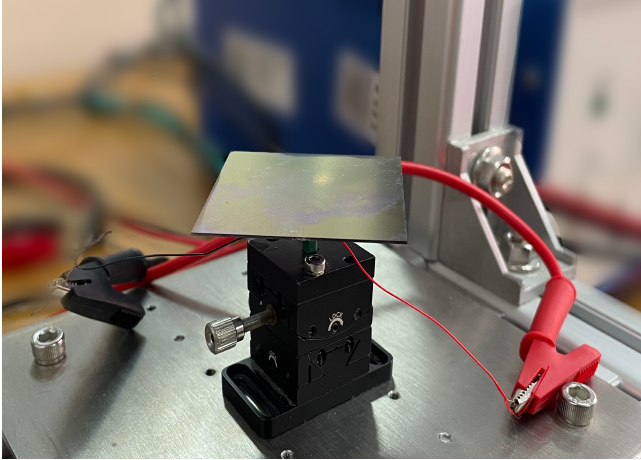
Figure 1. Acoustic manipulation